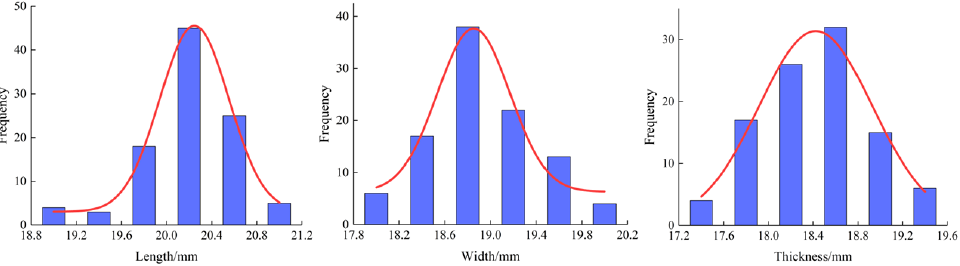
Figure 3. Triaxial size distribution of BSF frass aggregates.